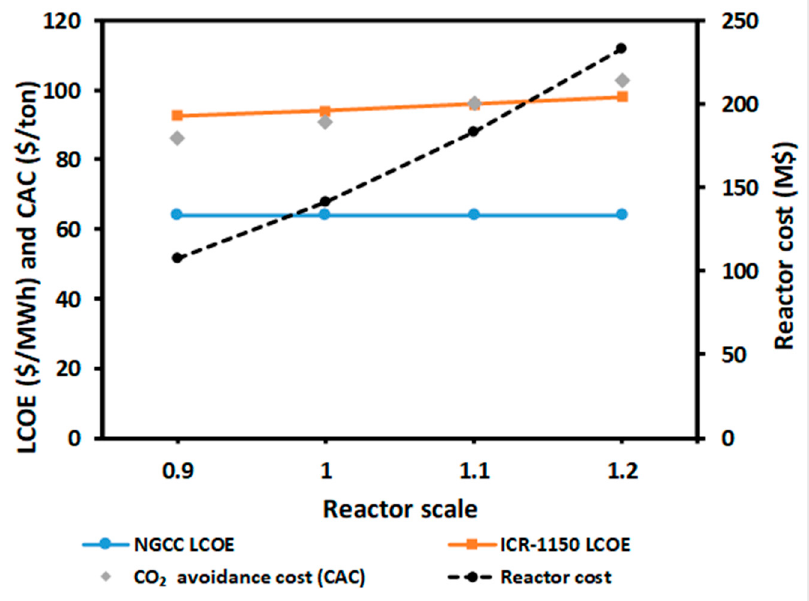
Figure 13. The effect of reactor scale factor (reactor diameter and height relative to the base case) on economic performance indicators.